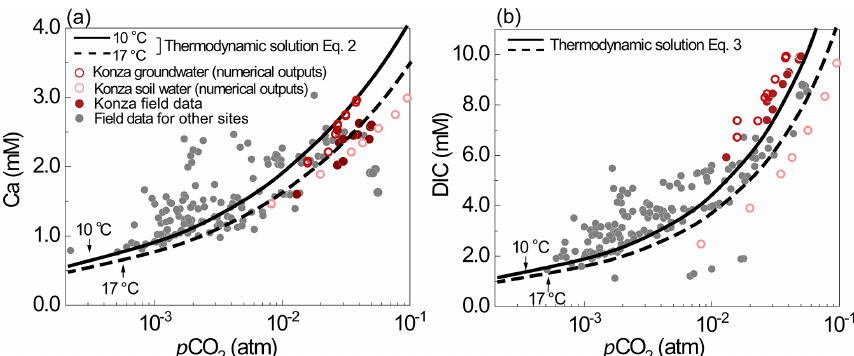
Figure 7. (a) Ca and (b) DIC data from the literature (gray dots) and prediction lines of Eqs. (2)–(3) at 10 ◦ C (solid line) and 17 ◦ C (dashed line). Measured spring water concentrations are from carbonate-dominant catchments in the literature: Abongwa and Atekwana (2015), Lopez-Chicano et al. (2001), Moral et al. (2008), Huang et al. (2015), Ozkul et al. (2010), Dandurand et al. (1982), Calmels et al. (2014), Kanduc et al. (2012), and Tsypin and Macpherson